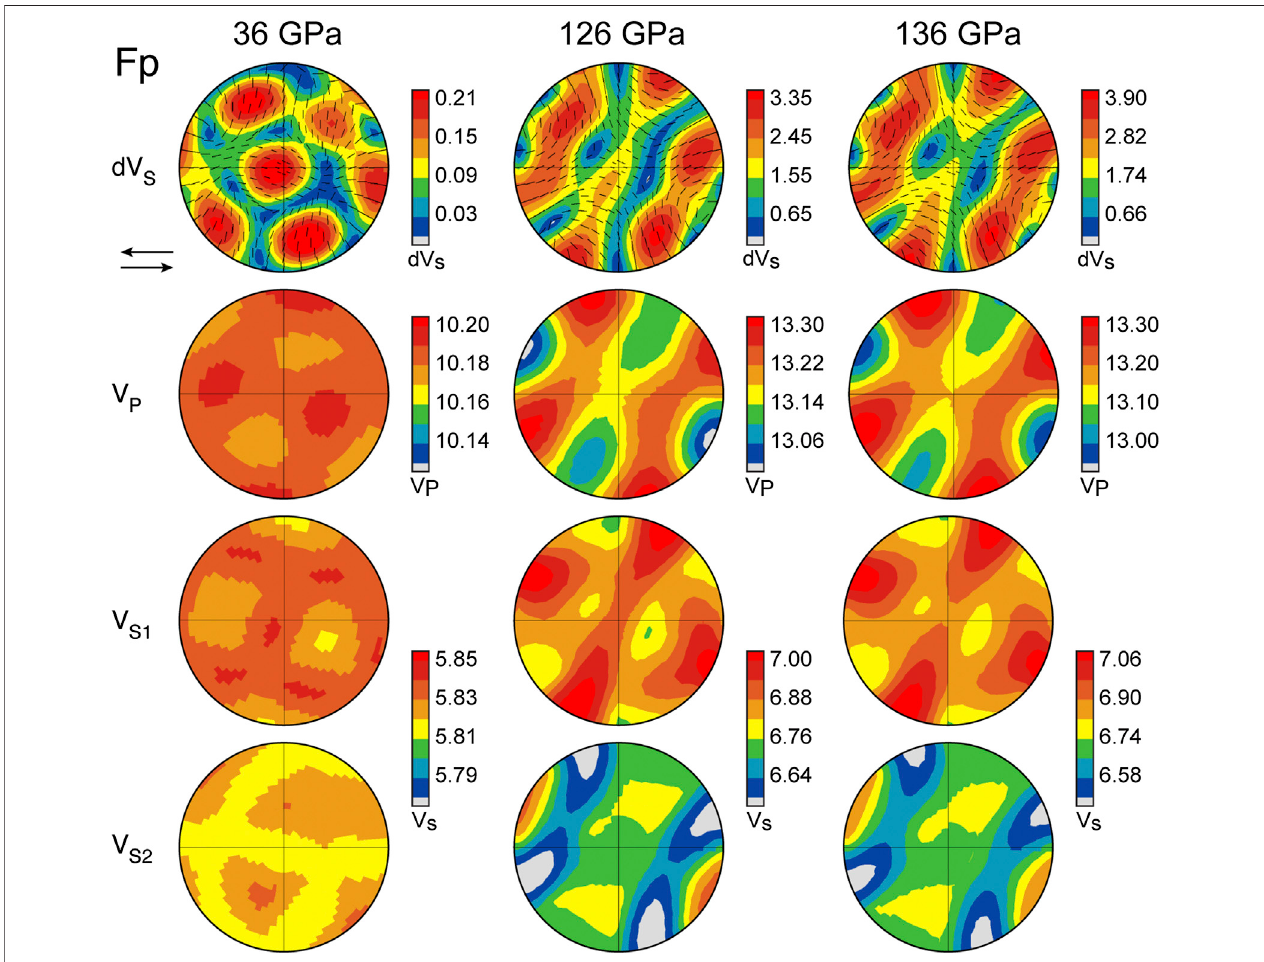
FIGURE 10 | Stereo-plots (produced by Beartex software) of shear wave splitting ( δ V S in percent), P-wave velocity (V P in km/s), the fast shear wave (V S1 in km/s), and the slow shear wave (V S2 in km/s) for a ferropericlase aggregate at 100% strain. VPSC textures used to create the stereo-plots are from extrapolating the results of Immooretal.(2018)topressureandtemperatureconditionsof36 GPaand2,000 K,126 GPaand3,000 K,and136 GPaand4,000 K.Elasticconstantsusedtocreate velocity surfaces are summarized in Supplementary Table S3 . Sense of shear is top left, shown by the arrows. Eigenvectors of the fast S-wave polarization are shown as black dashes. Note that each hemispheric projection shows a different range of δ V S